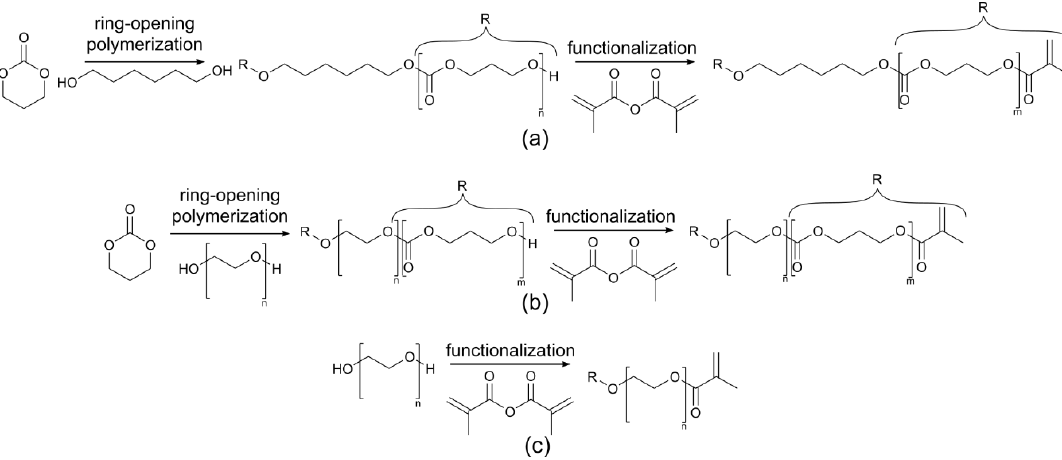
Figure 1. Ring-opening polymerization and functionalization schematic for photo-crosslinkable macromers. ( a ) Hexanediol was used as an initiator for the ring-opening polymerization of trimethylene carbonate (TMC), resulting in two-armed poly-TMC (PTMC), which was functionalized with MAAh, giving PTMC-dMA. ( b ) Commercial polyethylene glycol (PEG) ( M n = 10 kg/mol) was used as an initiator for TMC polymerization, resulting in a triblock-copolymer, which subsequently was functionalized into PTMC-PEG-PTMC-dMA. ( c ) Commercial PEG ( M n = 10 kg/mol) was functionalized, resulting in PEG-dMA. Table 1. Macromer properties. TMC conversion and number average molar masses ( M n) for PTMC- containing macromers and degree of functionalization (df) of all macromers as determined by 1 H- NMR. The M n for PEG as was provided by the manufacturer.